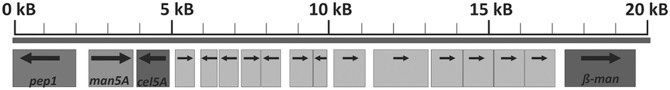
Genomic localization of the endomannanase gene of Thermobifida fusca strain TM51 according to the genome sequence data.Pale grey boxes without any marking represent conserved hypothetical protein encoding genes with unknown function and elements of peptide ABC transport system and transcriptional regulator genes, pep1: uncharacterized peptidase gene, man5A: endomannanase gene, cel5A: endoglucanase gene [30], β-man: beta-mannosidase gene [22]. On T. fusca genome the formerly published intracellular β-mannosidase is located in 13 kb proximity to the extracellular endomannanase.